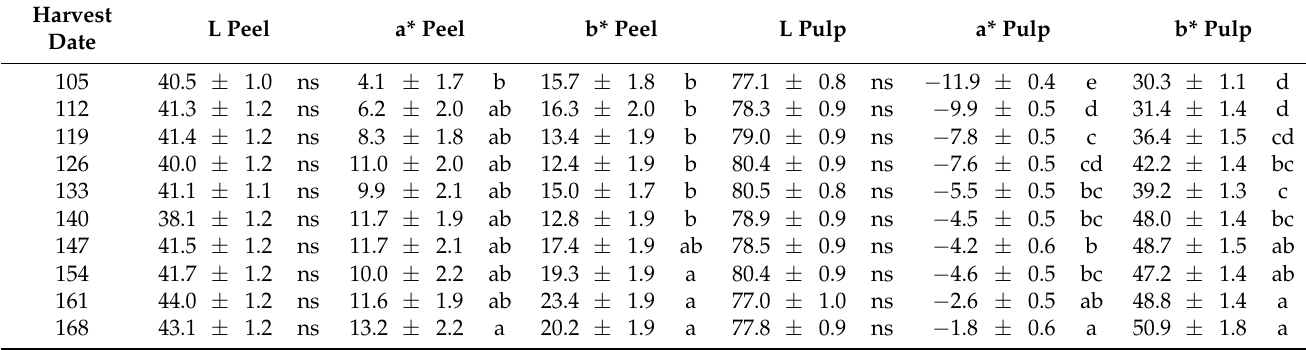
Table 3. Peel and pulp color of Osteen mango (mean ± SD, n = 12) at harvest date (days after full flowering). L indicates the color’s brightness, a* its position between red/magenta and green and b* its position between yellow and blue. Harvest